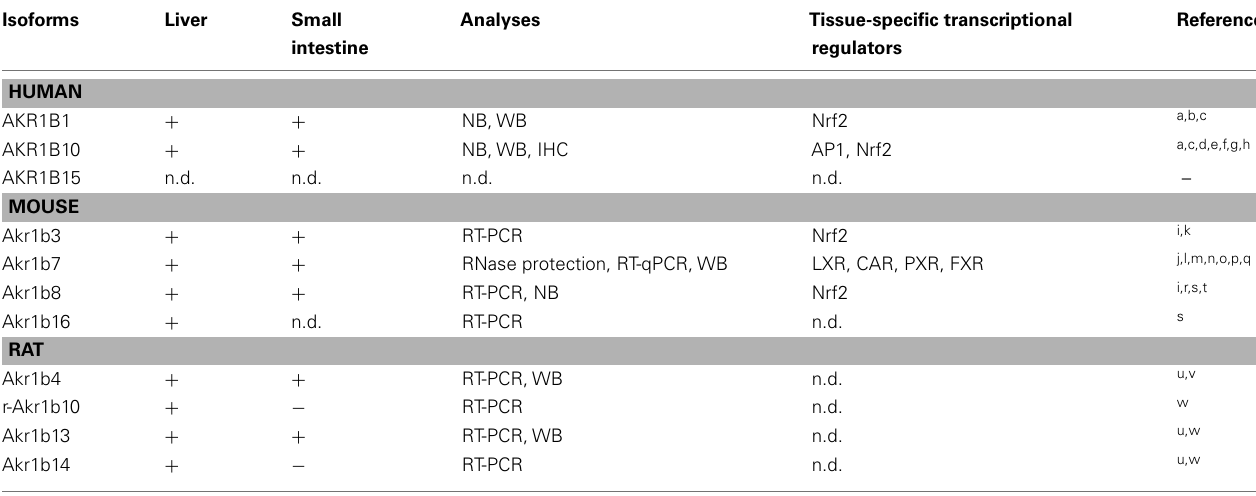
Table 4 | Expression of aldose reductases in liver and small intestine. Isoforms Liver Small Analyses Tissue-specific transcriptional intestine regulators